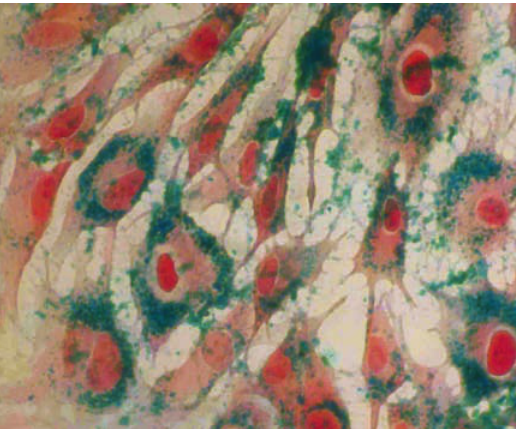
Figure 5 Intracytoplasmic blue particles in most mesenchymal stem cells (MSCs) (P3) incubated with ferric oxide nanoparticles and coupling with poly-l-lysine (Fe2O3-PLL) are clearly visible with Prussian blue staining (×400).